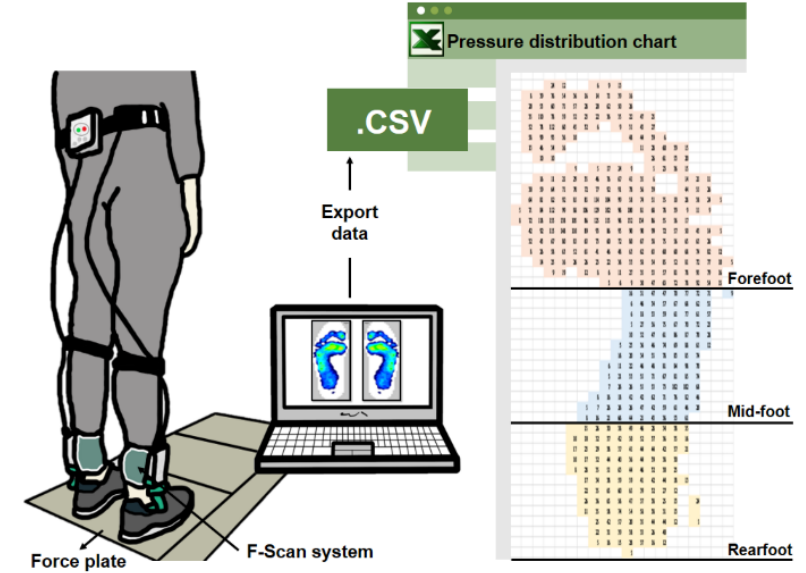
Figure 3. Experimental setup for plantar pressure measurements during gait, and the exporting plantar pressure distribution chart.